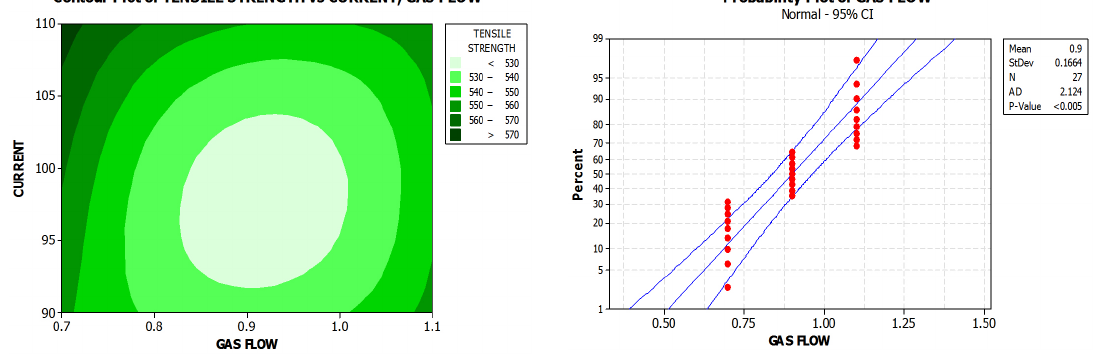
Figure 5. Probability plot of gas flow.